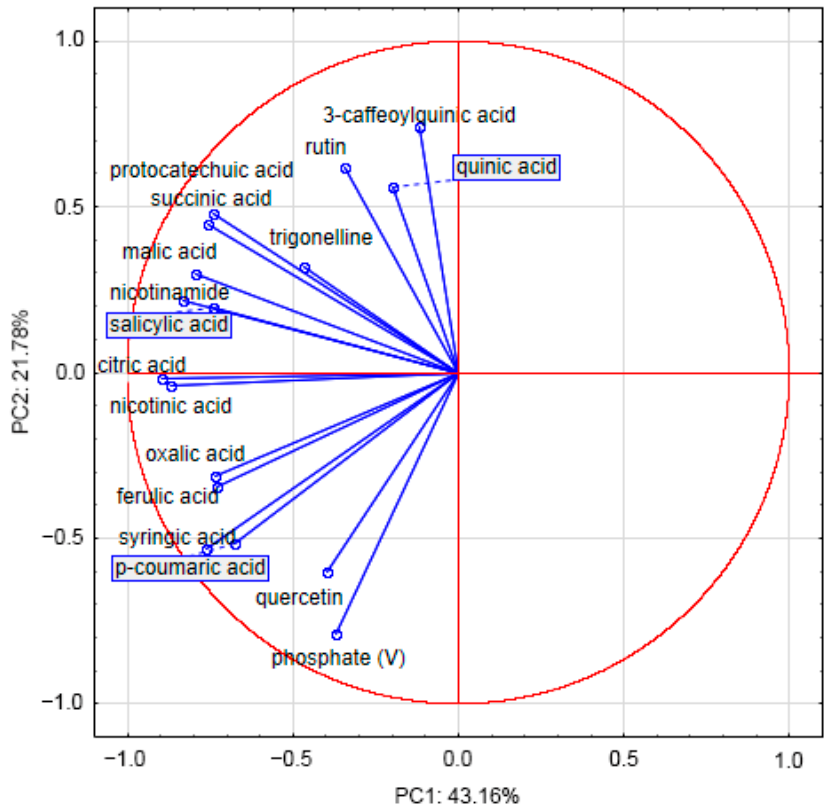
Figure 1. Projection—variable representation onto a plane.